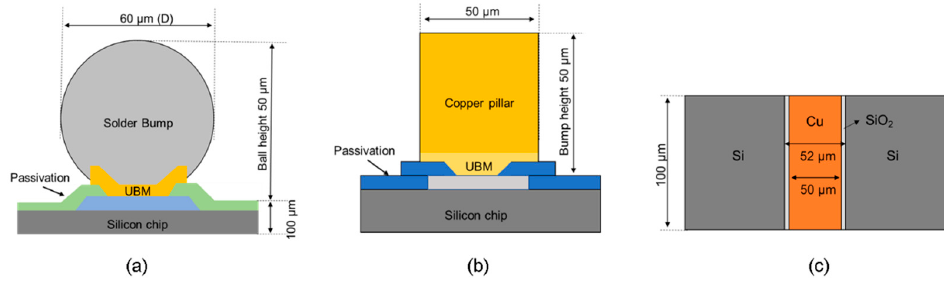
Figure 3. Schematic drawing of various interconnect structures: ( a ) solder ball; ( b ) Copper pillar microbump; ( c ) through-silicon via structure.